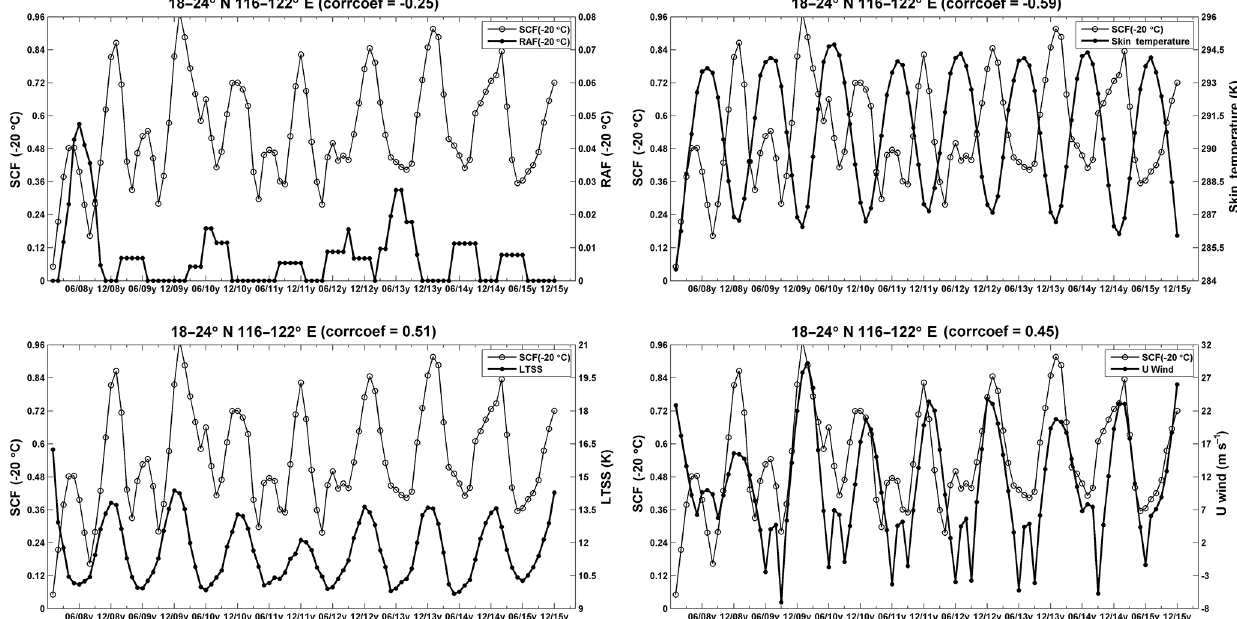
Figure 10. Similar to Fig. 8 but for − 20 ◦ C isotherm over the subtropics of the Northern Hemisphere (116–122 ◦ E, 18–24 ◦ N).